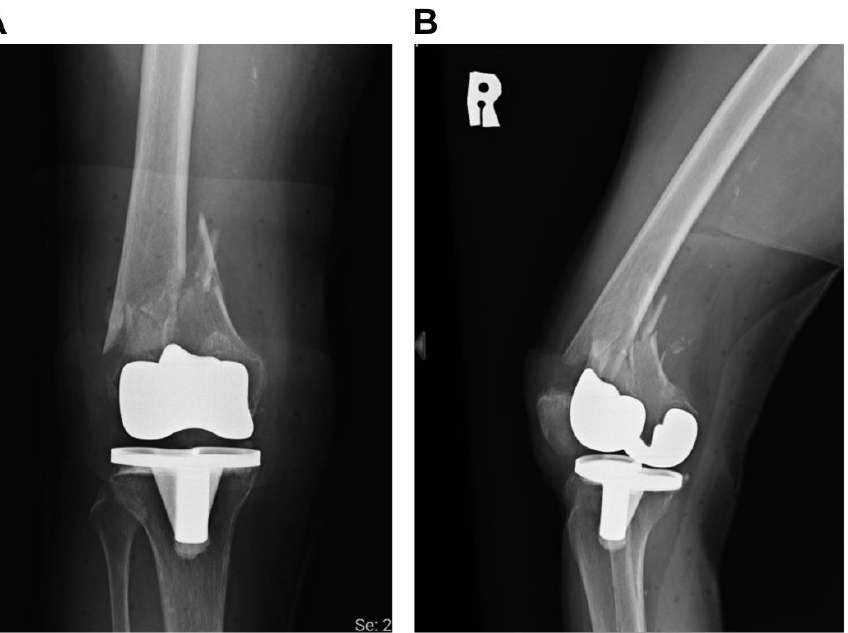
Figure 1. Preoperative radiographic images. ( A ) Anteroposterior (AP) view of knee. ( B ) Lateral view of knee. The patient was diagnosed with a periprosthetic distal femur fracture.